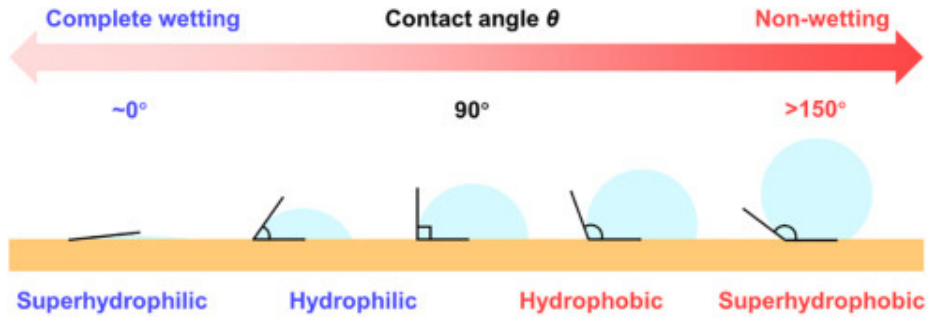
Figure 10. Classification of wettability of a surface [66] .